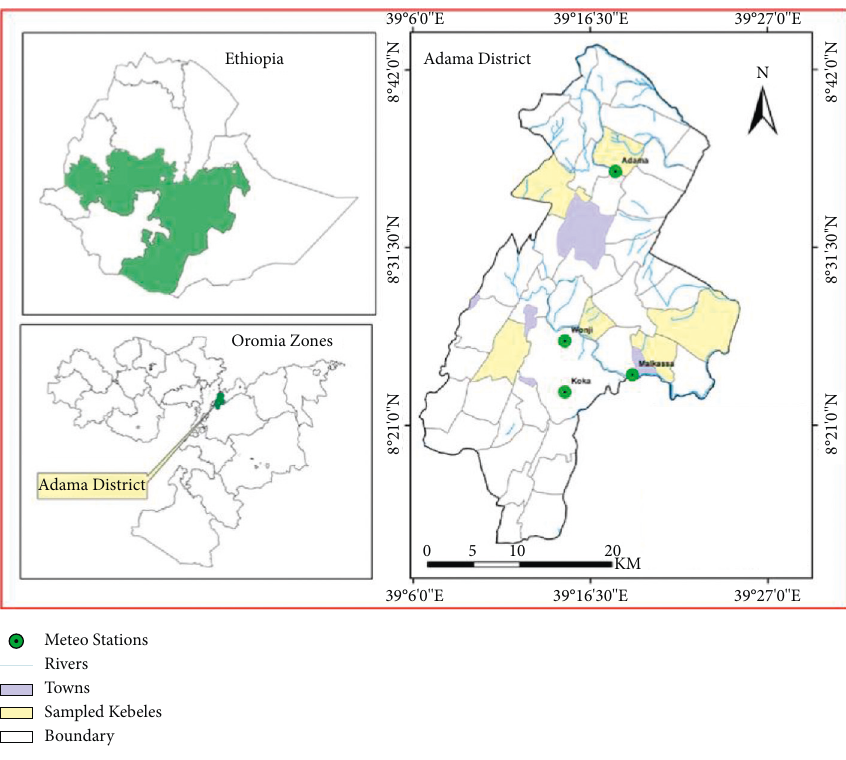
Figure 1: Location map of the study